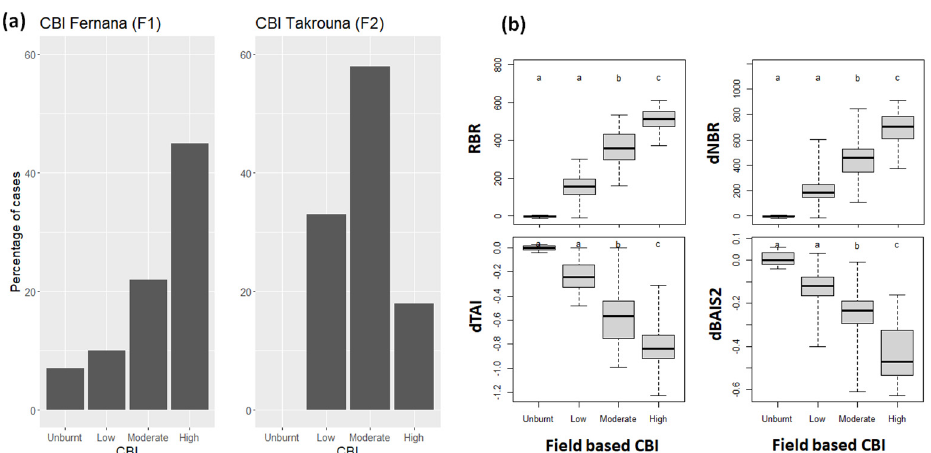
Figure 3. ( a ) Percentage of occupation of the different CBI classes using the entire data set (n = 193): unburnt (CBI: 0–0.1), low severity (CBI: 0.1–1.24), moderate severity (CBI: 1.25–2.24), and high severity (CBI: 2.25–3) for both fires of Fernana (F1) and Takrouna (F2); and ( b ) boxplots of the different spectral severity indices in each CBI class merging both fires. Letters indicated the separability among CBI classes according to the post-hoc Kruskal-Wallis Dunn